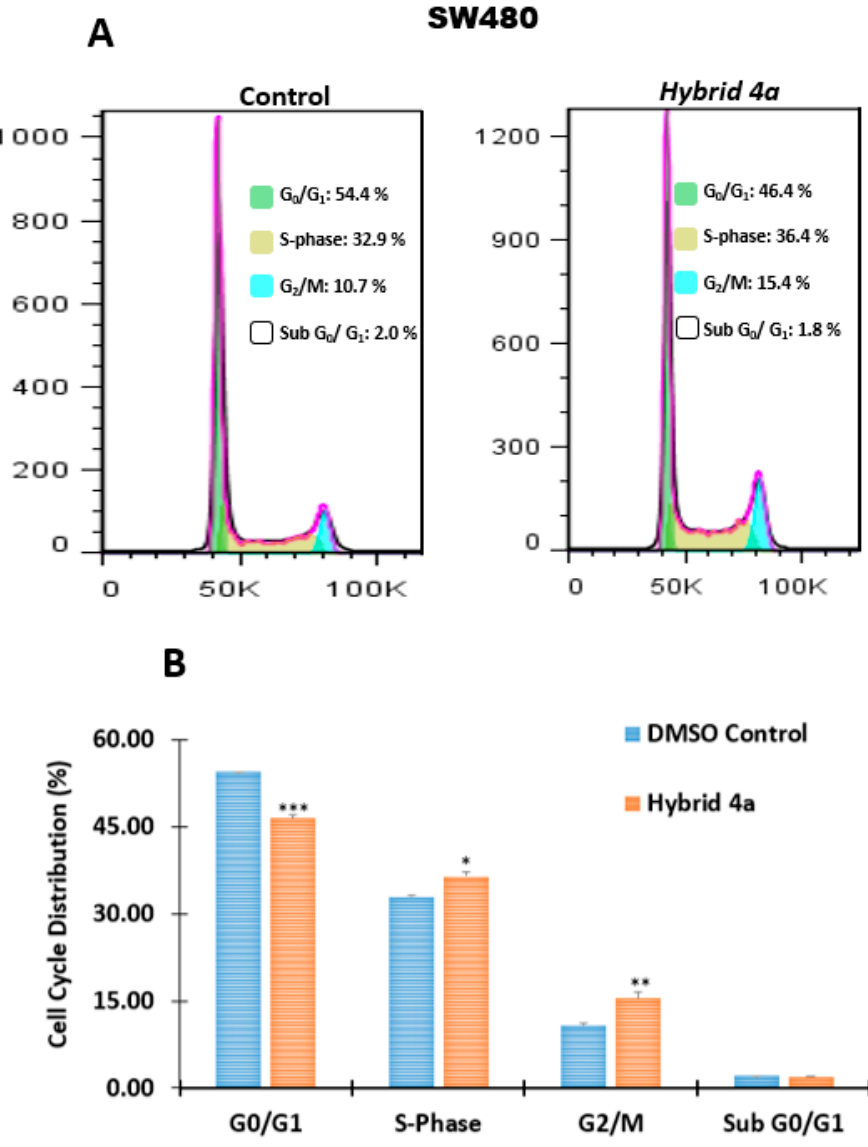
Figure 4. Percentage of cell cycle distribution in SW480 cells ( A) after the treatment with hybrid 4a . DMSO (1%) was used as vehicle control. Representation of data in bar chart form ( B ). DNA was stained with PI. Analysis was made by flow cytometry. One representative image is shown from two independent experiments. p values lower than 0.05 were considered statistically significant (* p < 0.05; ** p < 0.01; *** p < 0.001).